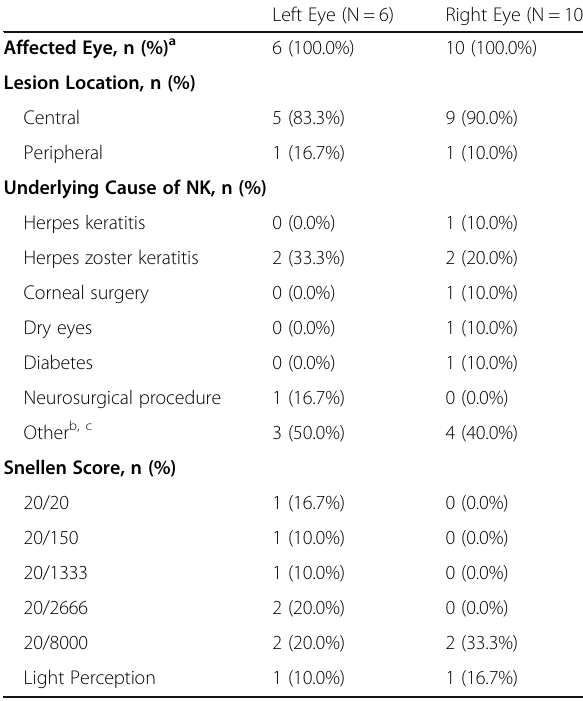
Table 3 Clinical Characteristics of Affected